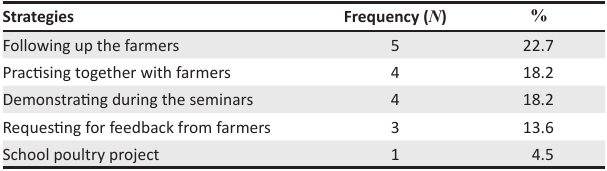
TABLE 4: Strategies used by information providers to ensure information is utilised ( N =